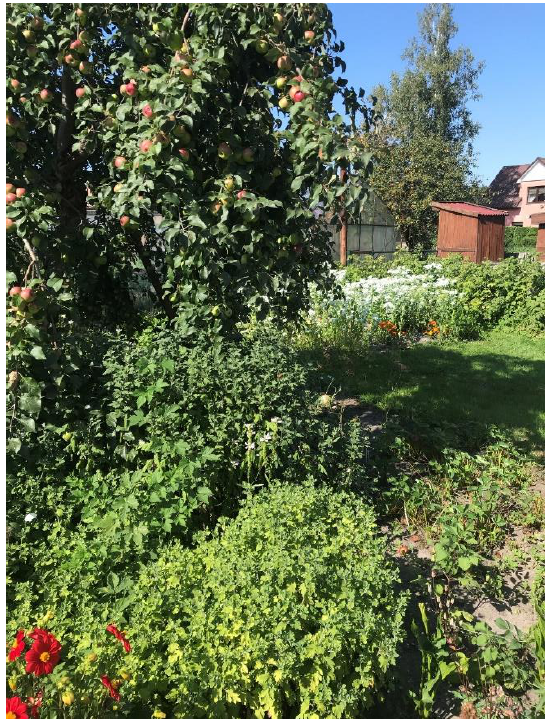
Figure 7. Home garden, Tauragė District, Lithuania.